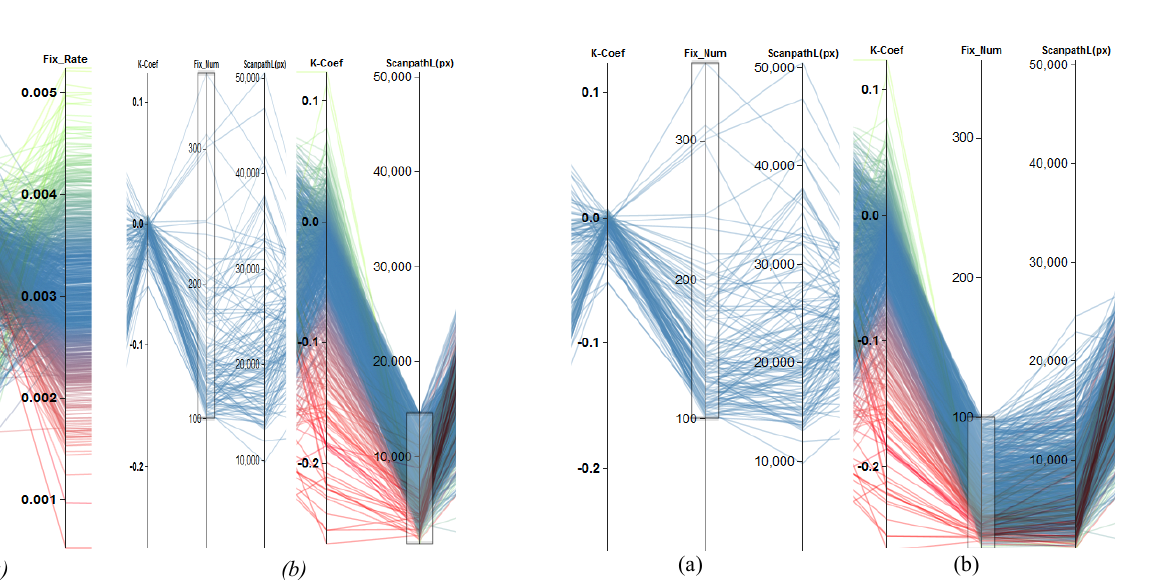
Figure 8. Examples of finding effects based on the cluster- ing of a single attribute. (a) shows the negative correlation between Ҡ Coef and FixRate . (b) depicts two different groups of behavior regarding the Ҡ Coef based on scanpath length . Scanpaths longer than about 15,000 px ((b), left) lead to Ҡ Coef values centered around zero. Shorter scanpaths ((b), right) result in a broader negative